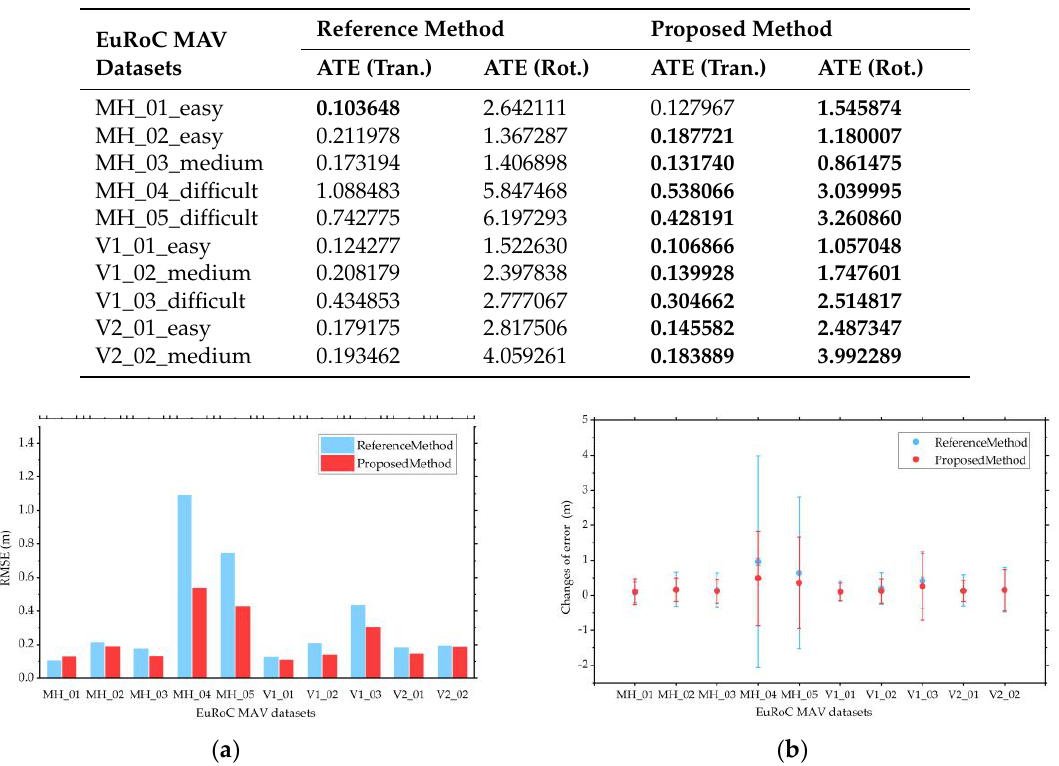
Table 3. Translation parts and rotation parts of ATE of the two methods on several EuRoC MAV datasets. The numbers in bold indicate that these terms are better than those of another method. The unit of translation part is meter and the unit of rotation part is degree.